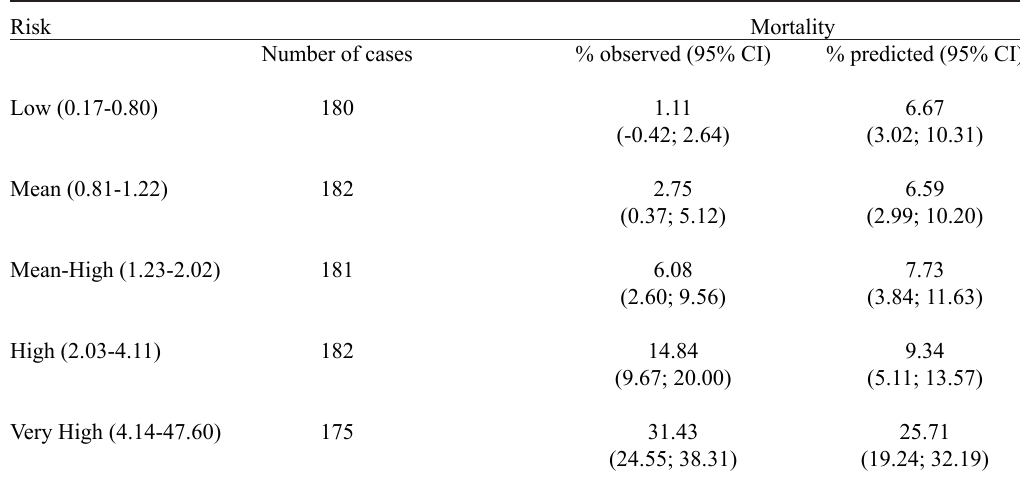
Table 3. EuroSCORE II calibration - Analysis by risk group.